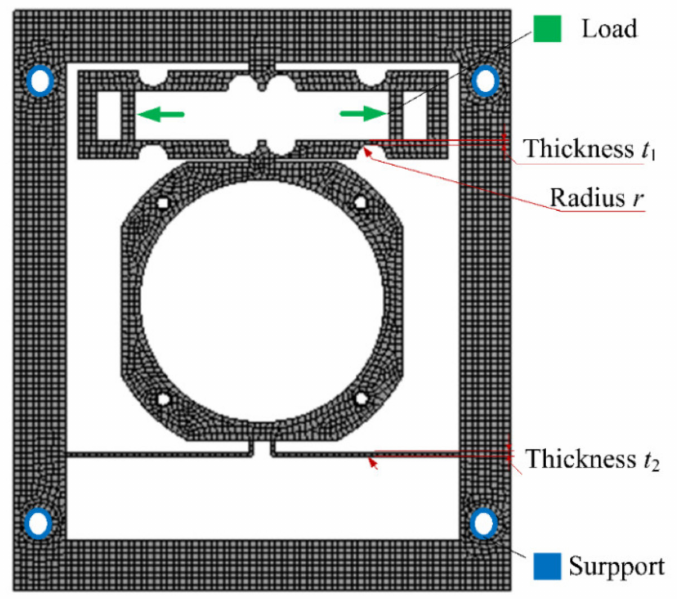
Figure 8. FEM model of the